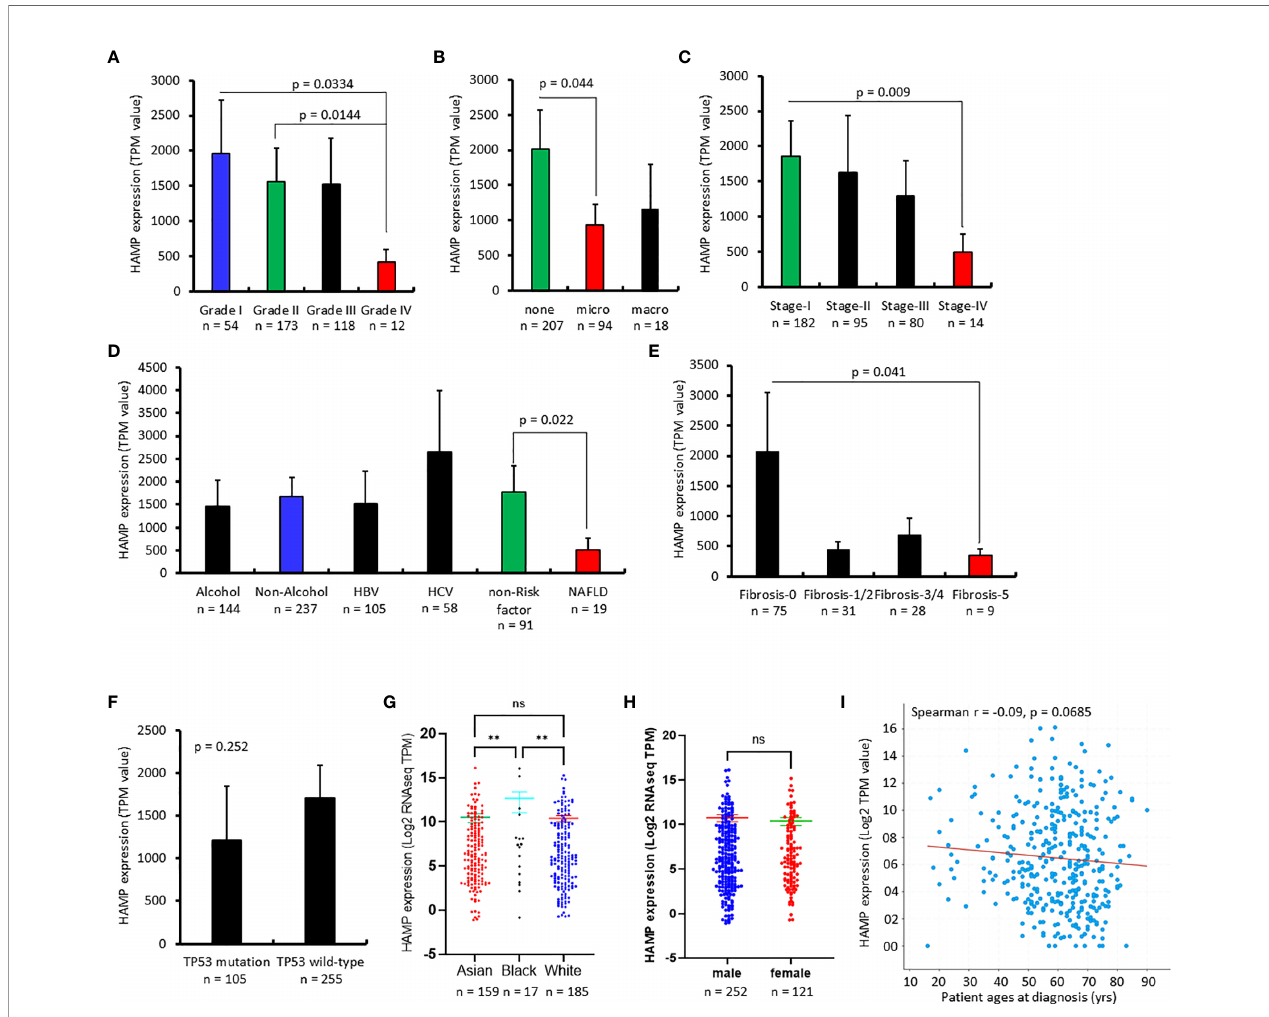
FIGURE 2 | Hepcidin downregulation correlates with cancer risk factors and aggressiveness in liver cancers. (A – H) . Hepcidin expression (TPM value) from four datasets (21 – 24) plus the TCGA project was downloaded from the cBioportal platform. Case numbers in each group were listed at the bottom of the fi gure. The p- value as shown was from the Student t -test. The double asterisks in (G) indicate a signi fi cant difference (p < 0.01). ns, no signi fi cance. (I) Correlation of hepcidin expression levels with patient ages was analyzed on the cBioportal platform with 1070 cases of HCC